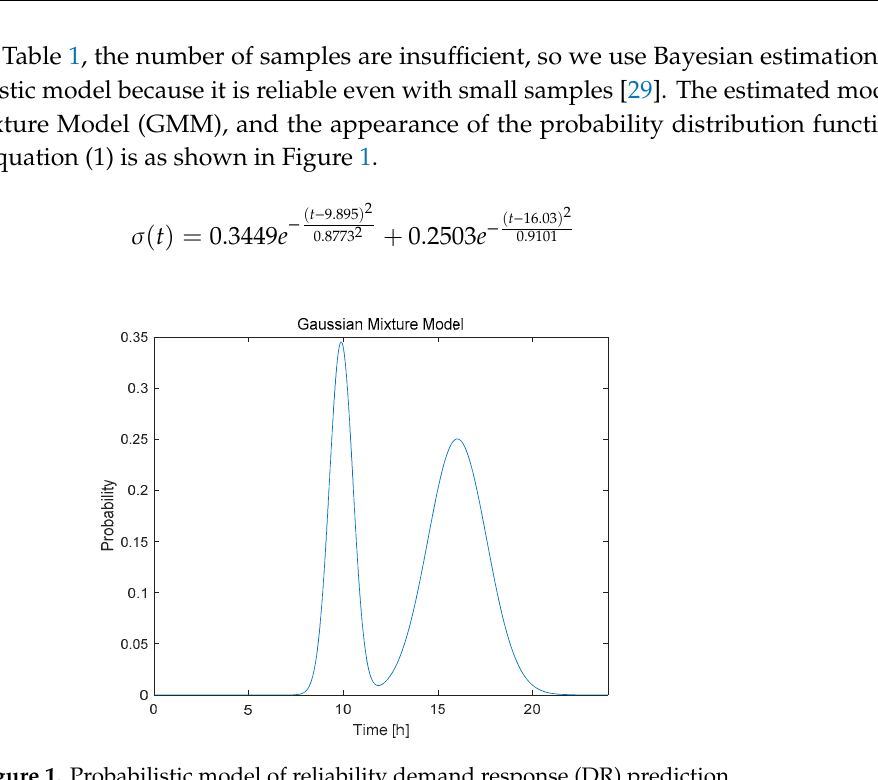
Figure 1. Probabilistic model of reliability demand response (DR) prediction.